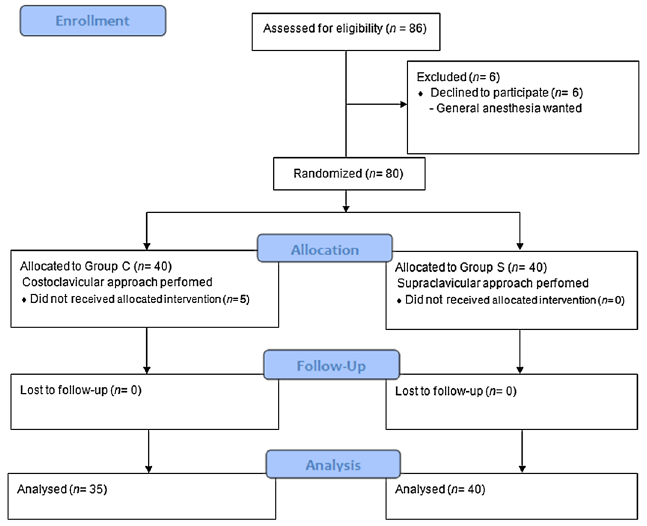
Figure 3. Consolidated standards of reporting trials (CONSORT) flow diagram.